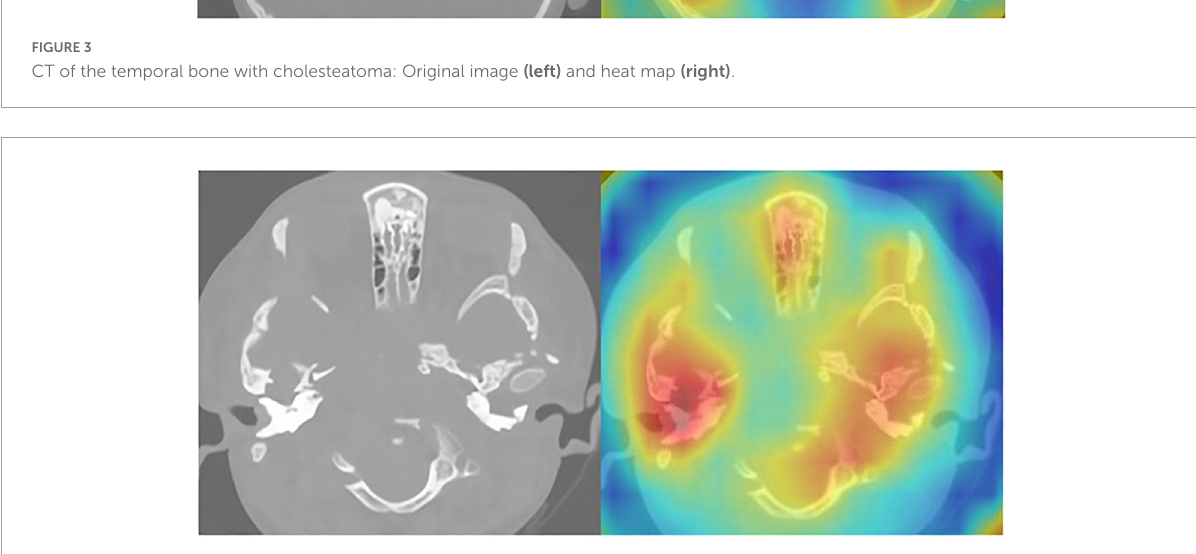
FIGURE4 CT of the temporal bone with LCH: Original image (left) and heat map (right)